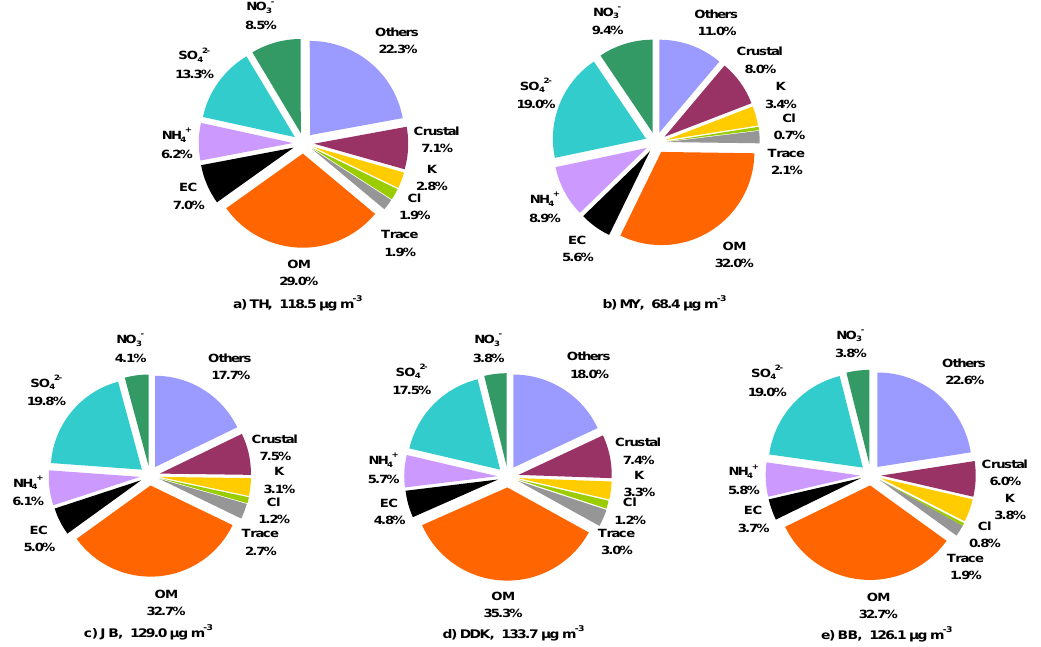
Fig. 4. Average PM 2 . 5 speciation at TH and MY in Beijing and at JB, DDK, and BB in Chongqing during March 2005 through February